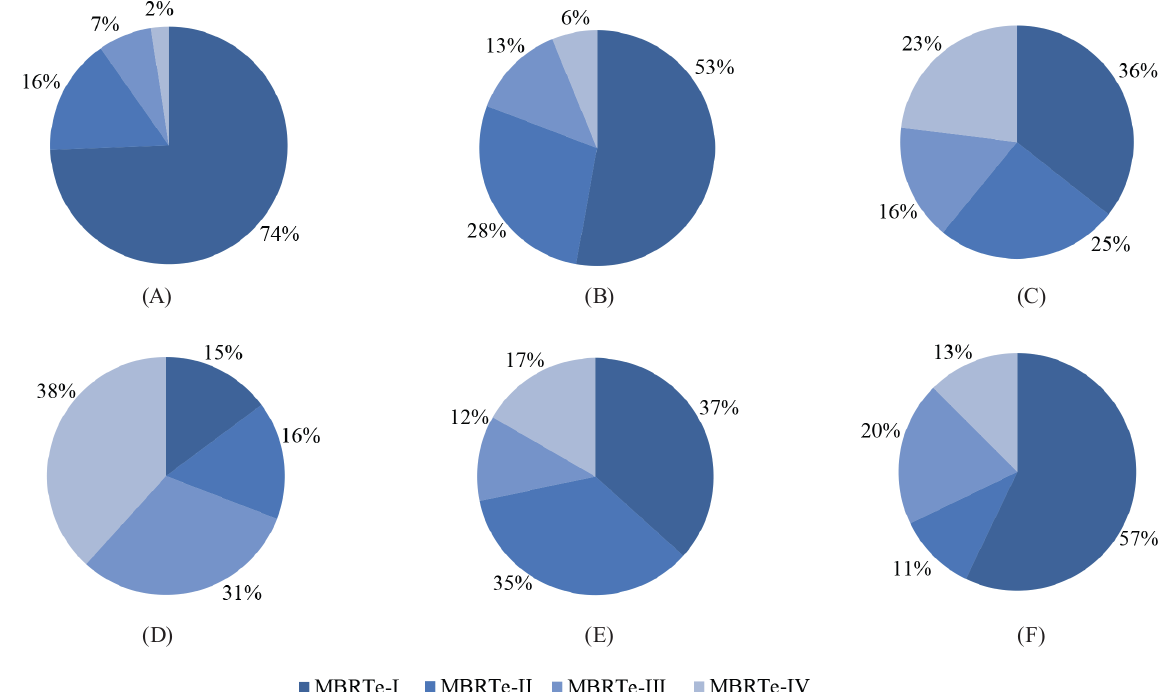
Figure 5 Distribution of MBRTe samples in each association ( A‒F ) showing the herd health and compliance with good practices